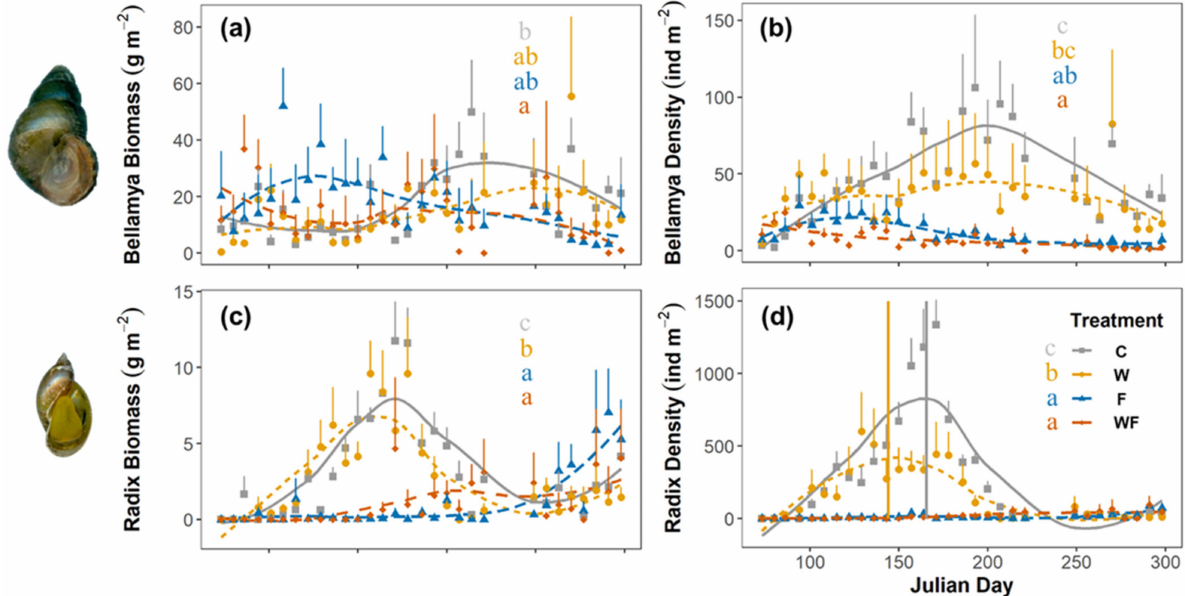
Figure 2. Biomass and density of populations of the two snail species changed over time in different treatments. Biomass ( a ) and density ( b ) of B. aeruginosa , and biomass ( c ) and density ( d ) of R. swinhoei . The curves were fitted from the LOESS model in R package ggplot2. Vertical bars are standard errors. The vertical lines in panel ( d ) indicate the time of the peak density extracted from the fitted Weibull functions, and the time of peak density for the warming with fish (W) treatment was 21 days earlier than the control (C). The curves were fitted using the LOESS model in the R package ggplot2. Small letters indicate significant difference between the four treatments. C for control, W for warming without fish, F for fish present alone and WF for warming with fish. Please note that the y -axis has a different scale for each